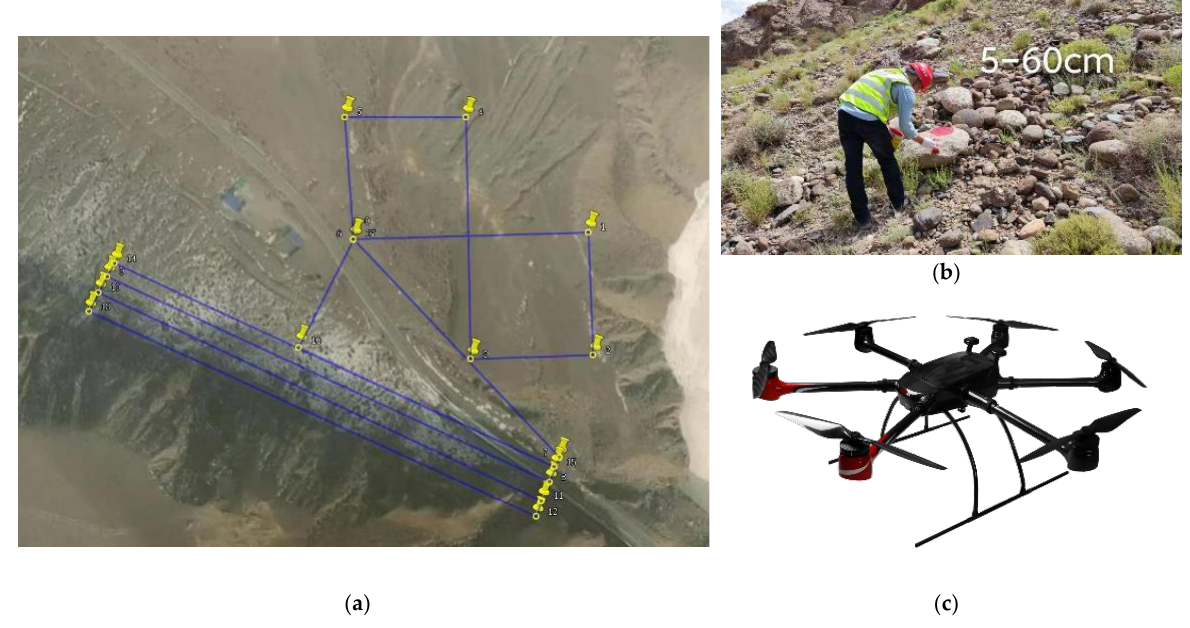
Figure 2. UAV data acquisition. ( a ) The flights of the study site. ( b ) The spray-painted stone. ( c ) The six-rotor flight platform. Table 1. The parameters of the flight platform and camera system.